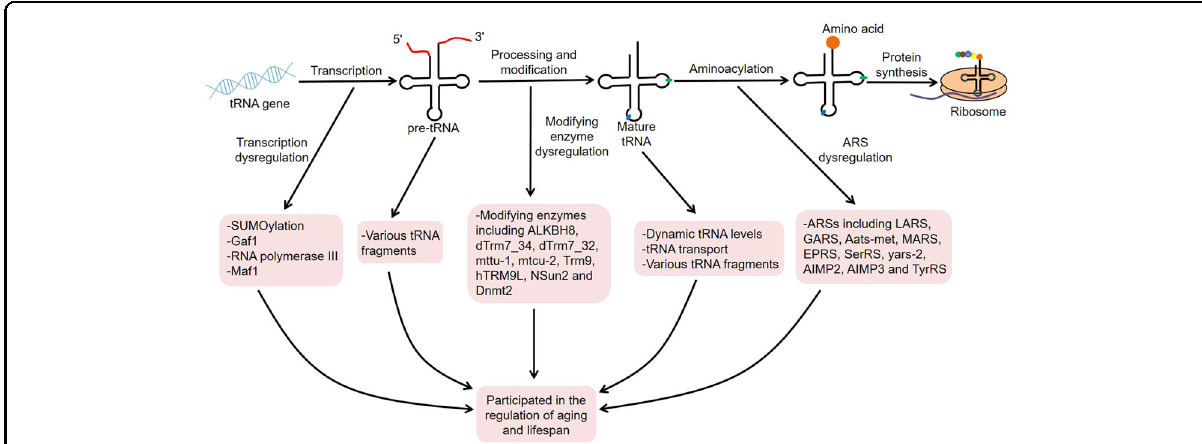
Fig. 1 Roles of tRNA-associated metabolism in aging and lifespan. The tRNA genes are transcribed into pre-tRNAs, which are then transformed into mature tRNAs after a series of processing and modi fi cations. Subsequently, mature tRNAs are involved in protein translation. During this process, tRNA-associated metabolism, such as tRNA transcription, tRNA molecules, tRNA modi fi cations, tRNA aminoacylation, and tRNA derivatives, plays an important role in aging and